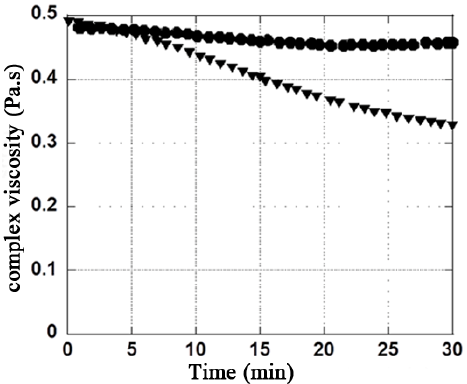
Figure 4. Kinetic of hyaluronic acid degradation (HA, 10 g·L − 1 ) according to mannitol concentration (10 g·L − 1 (  ) or 35 g·L − 1 (  )) measured by the variation of the complex viscosity |  *| as a function of the time of hydrogen peroxide induced oxidative stress O in 3 mL HA solution). (0.6 mL of H 2 2